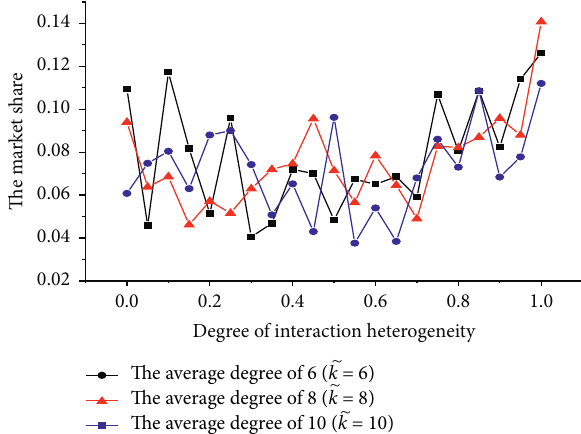
Figure 9: Influence of interaction heterogeneity on the diffusion scale based on different network